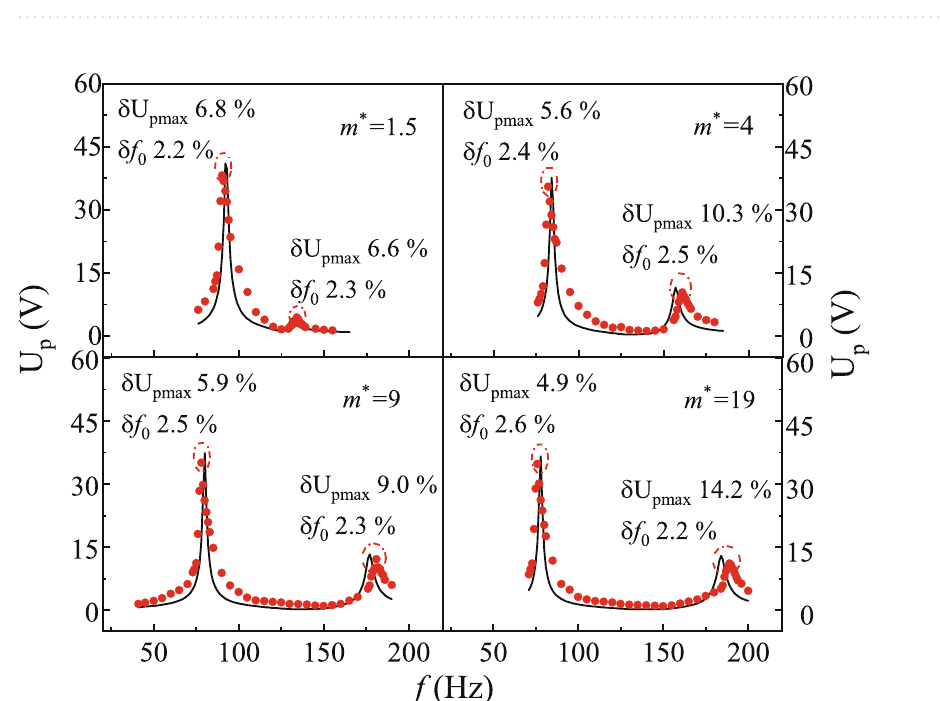
Figure 11. The U p - f curves under the different mass ratios m * for the